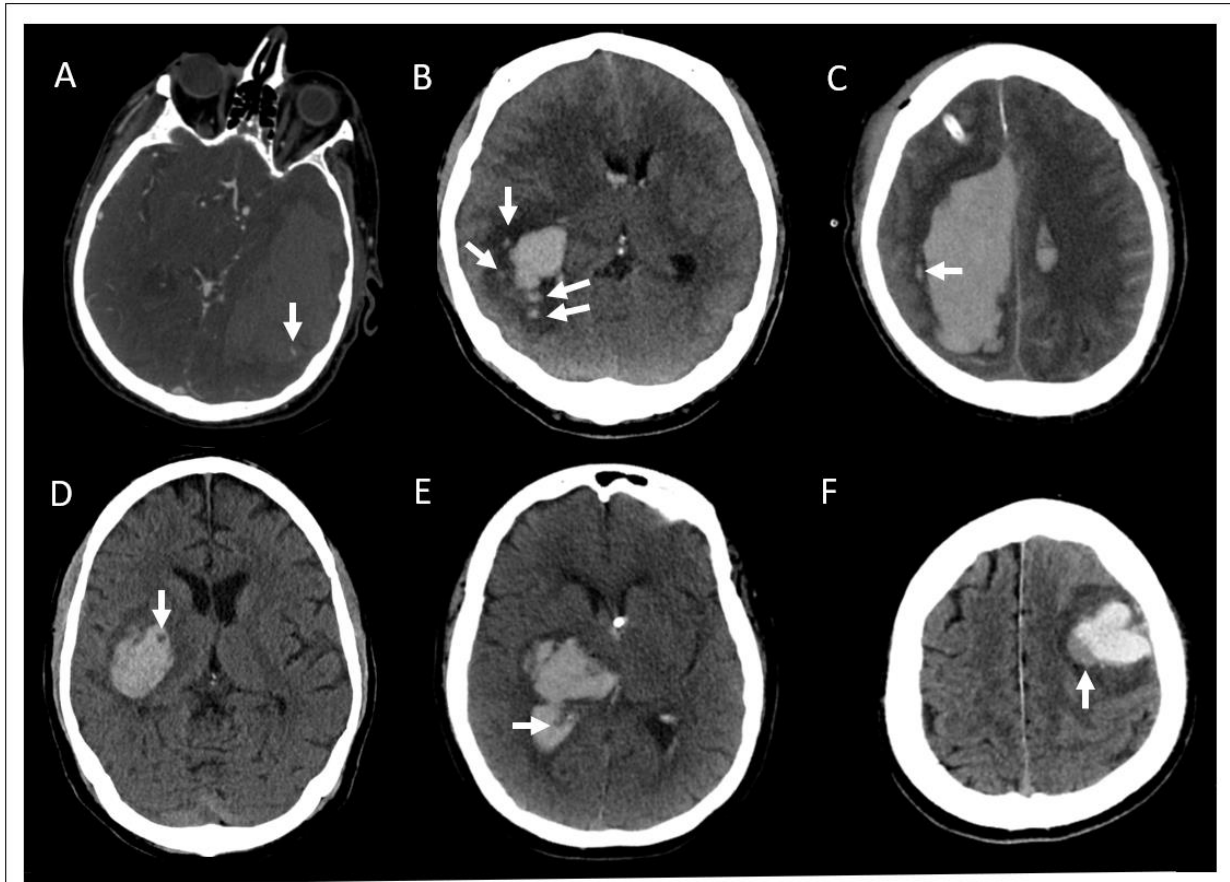
Figure 1. Diagnostic imaging markers associated with hematoma expansion in intracerebral hemorrhage. The various signs associated with hematoma expansion indicated by white arrows in each panel. Spot sign is seen on computed tomography angiography (CTA), the others are found on non-contrast computed tomography head (CTH). ( A ) Spot sign; ( B ) island sign; ( C ) satellite sign; ( D ) black hole sign; ( E ) swirl sign; ( F ) blend sign.